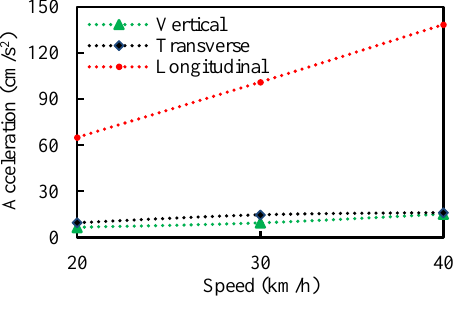
Figure 15. The accelerations of the track beam with one train braking in the middle of the bridge.